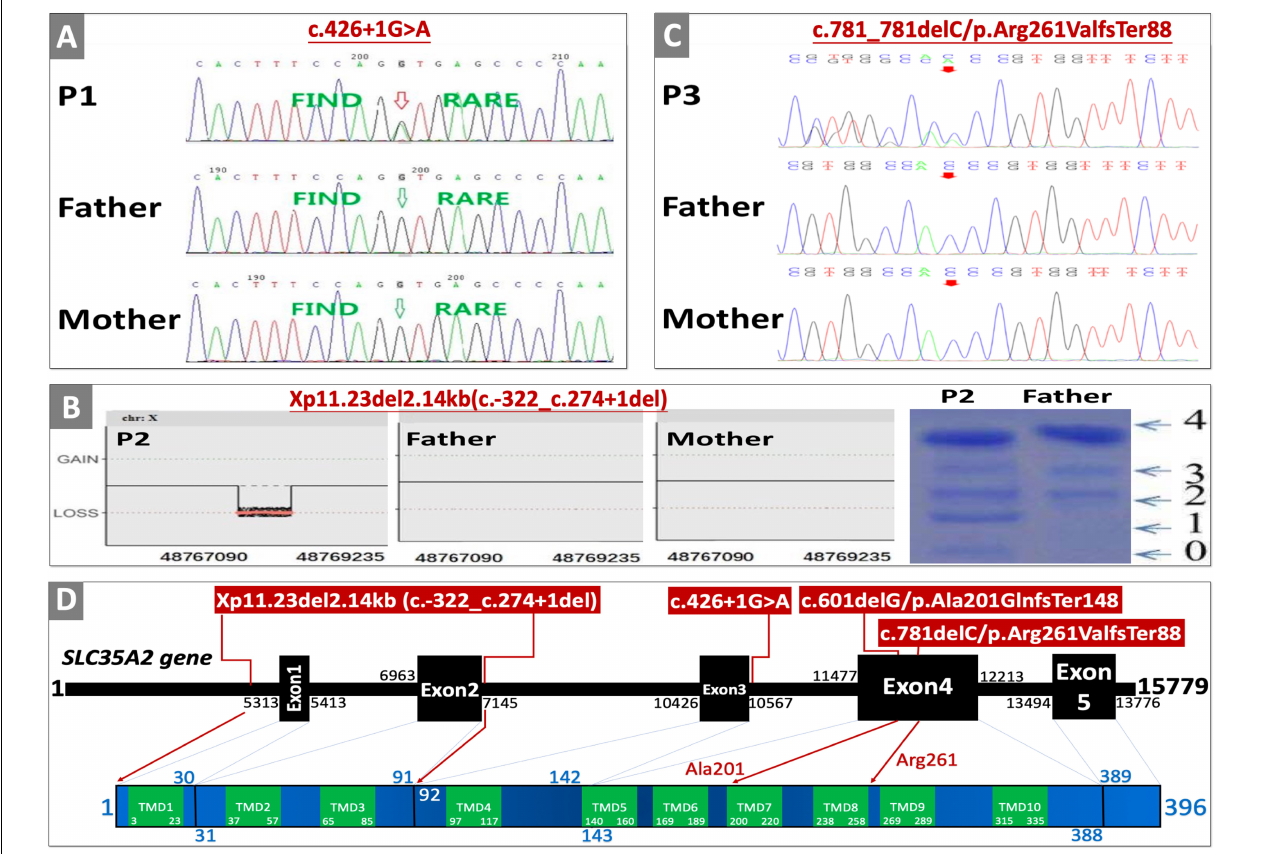
FIGURE 1 | Genetic testing, transferrin isoelectric focusing, cDNA changes, and effects on protein domain. (A) Sanger sequencing confirmation of P1. (B) Whole exome sequencing copy number variant (CNV) analysis result, and serum transferrin isoelectric focusing results of P2 (0, 1, 2, 3, and 4 are the numbers of sialic acid glycosylated with transferrin corresponding to transferrin not glycosylated with sialic acid, transferrin glycosylated with monosialic acid, disialic acid, trisialic acid, and tetrasialic acid). (C) Sanger sequencing confirmation of P3. (D) Location of variants on SLC35A2 gene with corresponding amino-acid location and transmembrane domains (TMD); SLC35A2 gene NCBI reference sequence of NG_034300.1, transcript reference of NM_001042498.2, and protein reference of NP_001035963.1, and GRCh37/hg19 were used for cDNA and amino acid changes. Sanger sequencing confirmation of P4 and parents were published in the Chinese literature (Tian et al.,